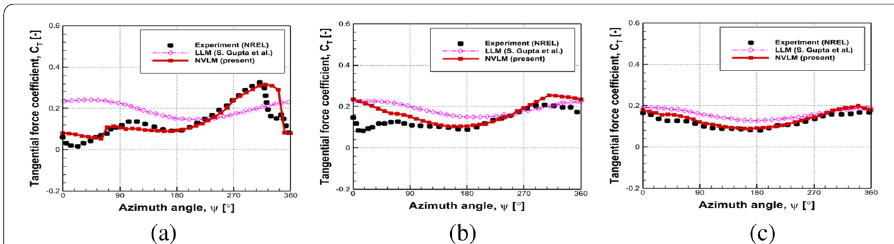
Fig. 17 Azimuthal variation of tangential force coefficient acting at specific radial positions for V and β 30º: ( a ) r/R 0.47, ( b ) r/R 0.63, and ( c ) r/R = = =